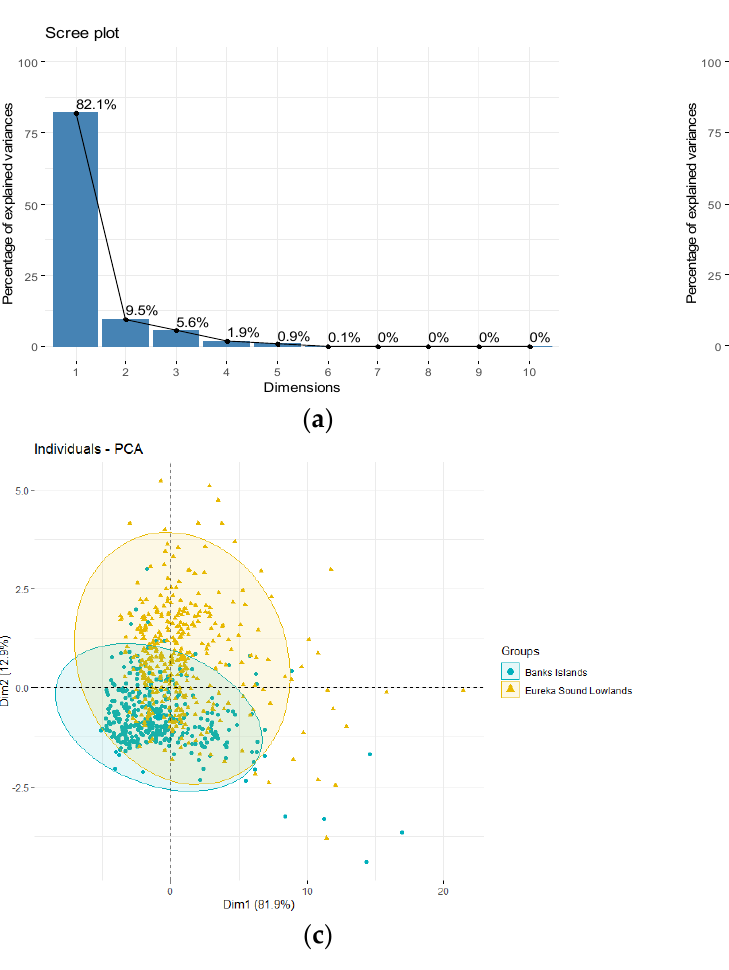
Figure 8. Principal Component Analysis (PCA) of Haralick texture features of RTS samples from Banks Island and the Eureka Sound Lowlands. Scree plots ( a , b ) show eigenvalues of thirteen textures. ( c ) Cluster plot of PC1 and PC2.